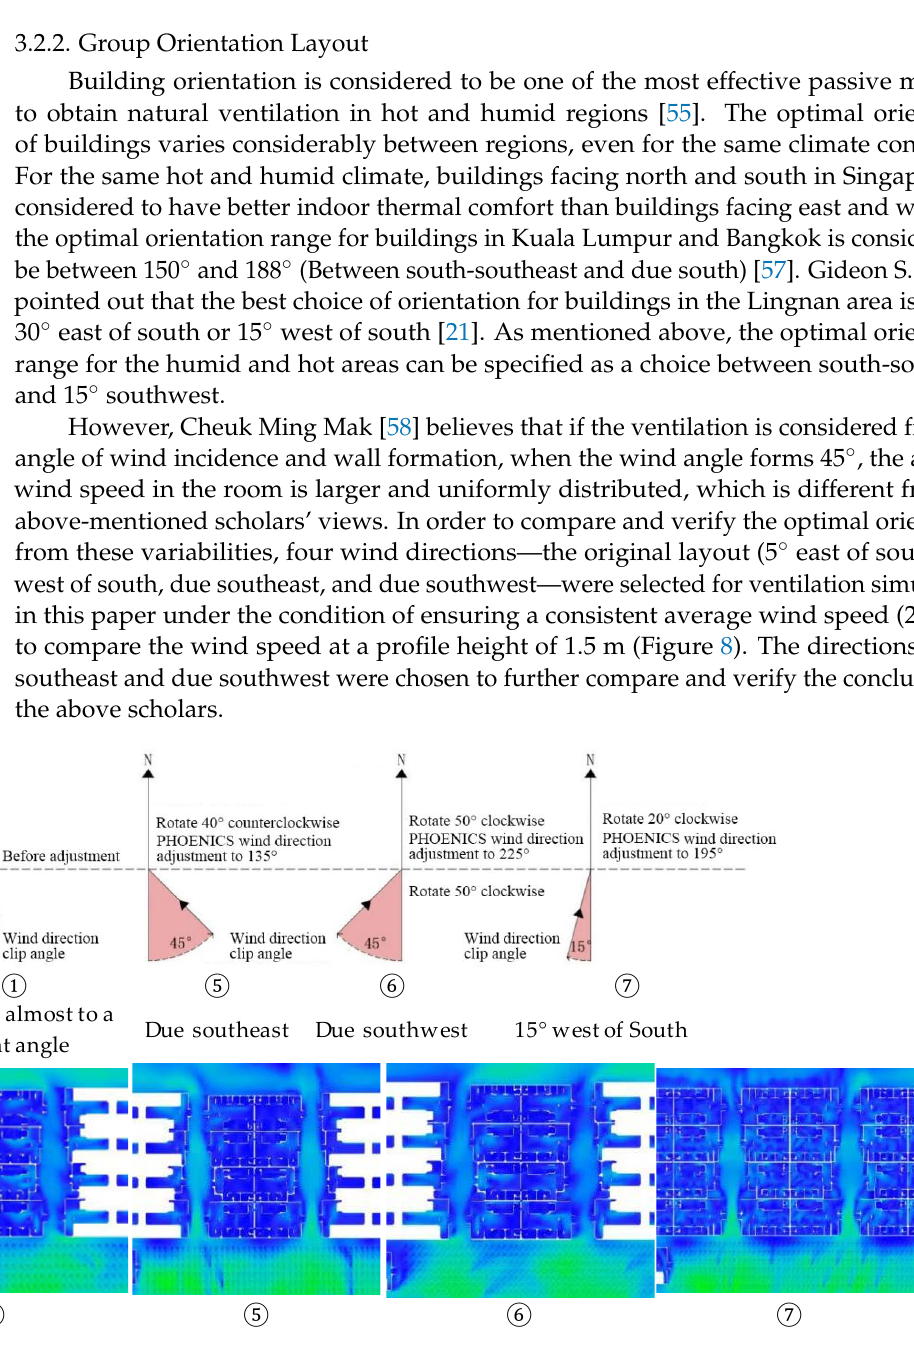
⑦ Figure 8. Process of community orientation optimization and simulation results. Figure 8. Process of community orientation optimization and simulation